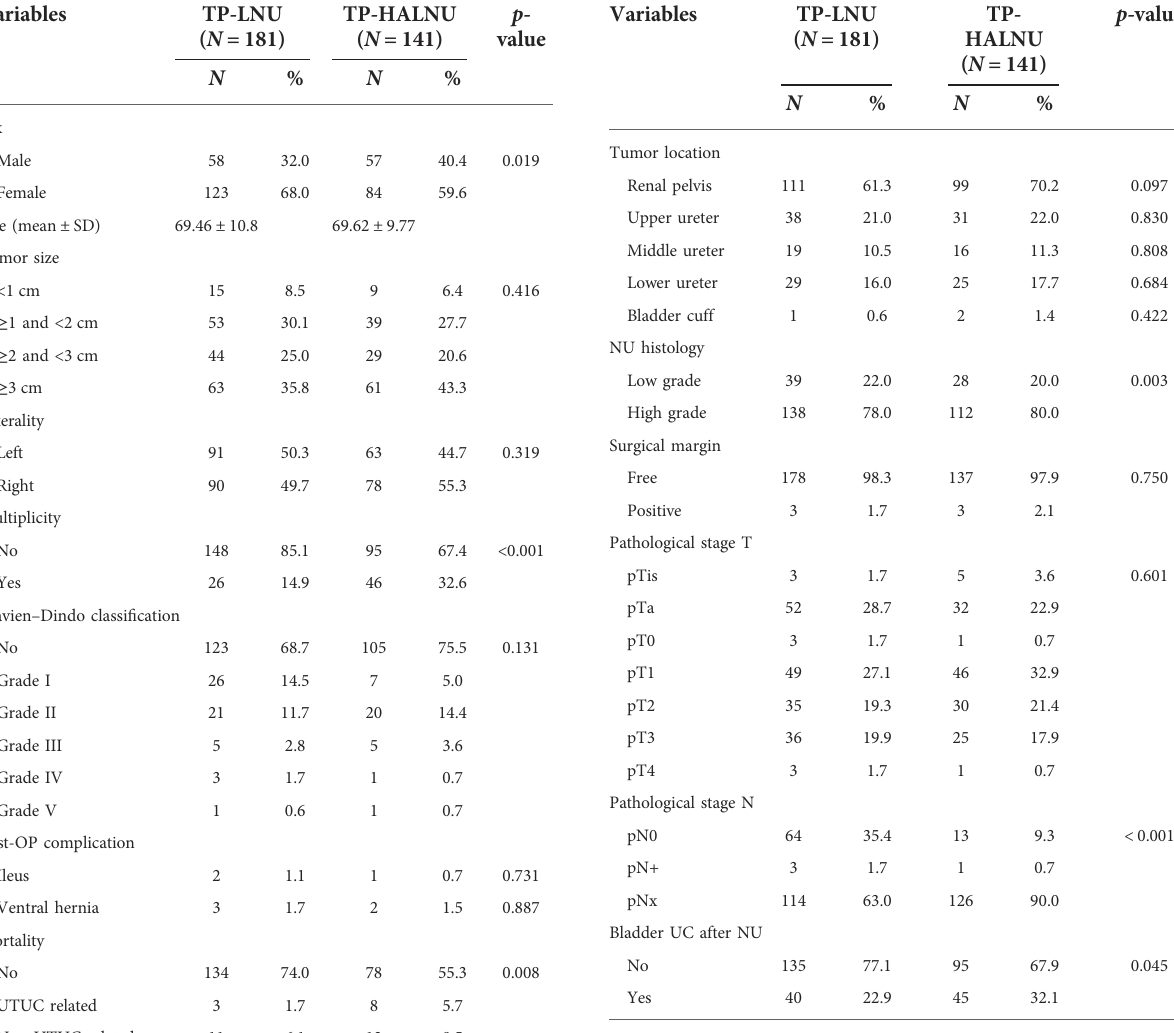
TABLE 1 Demographic data of UTUC patients. TABLE 2 Tumor characteristics of UTUC